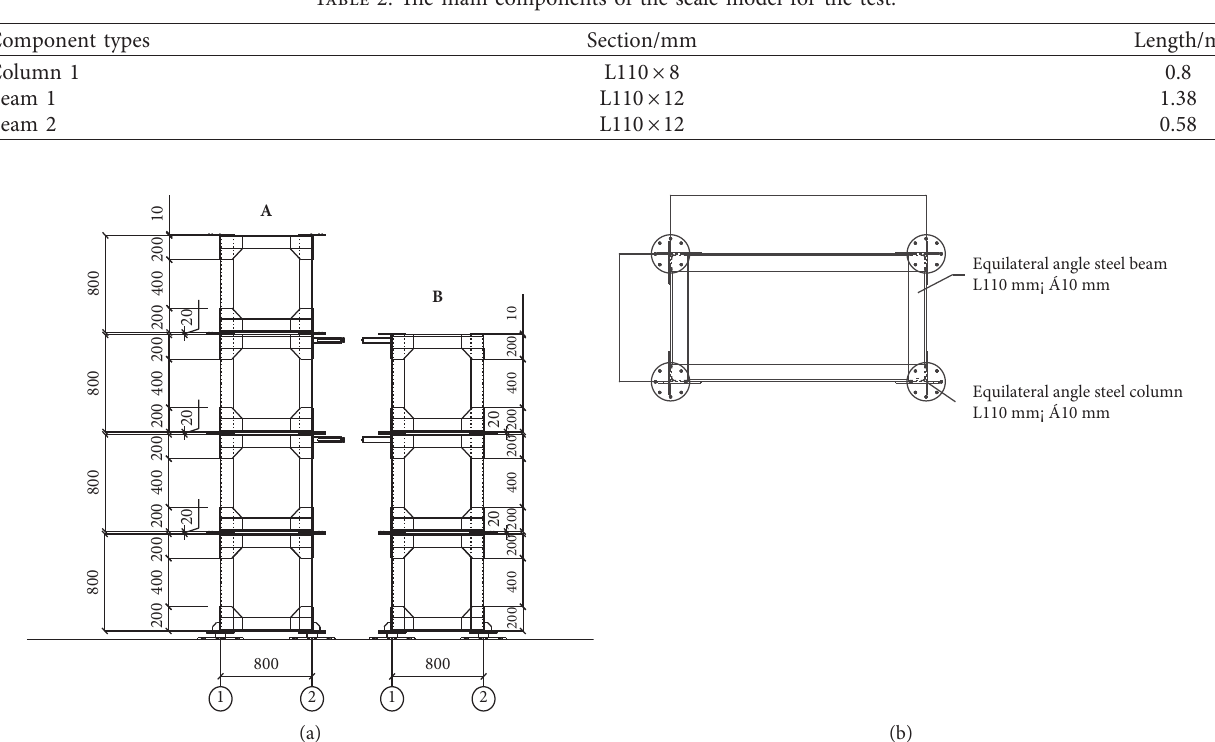
Table 2: The main components of the scale model for the test.